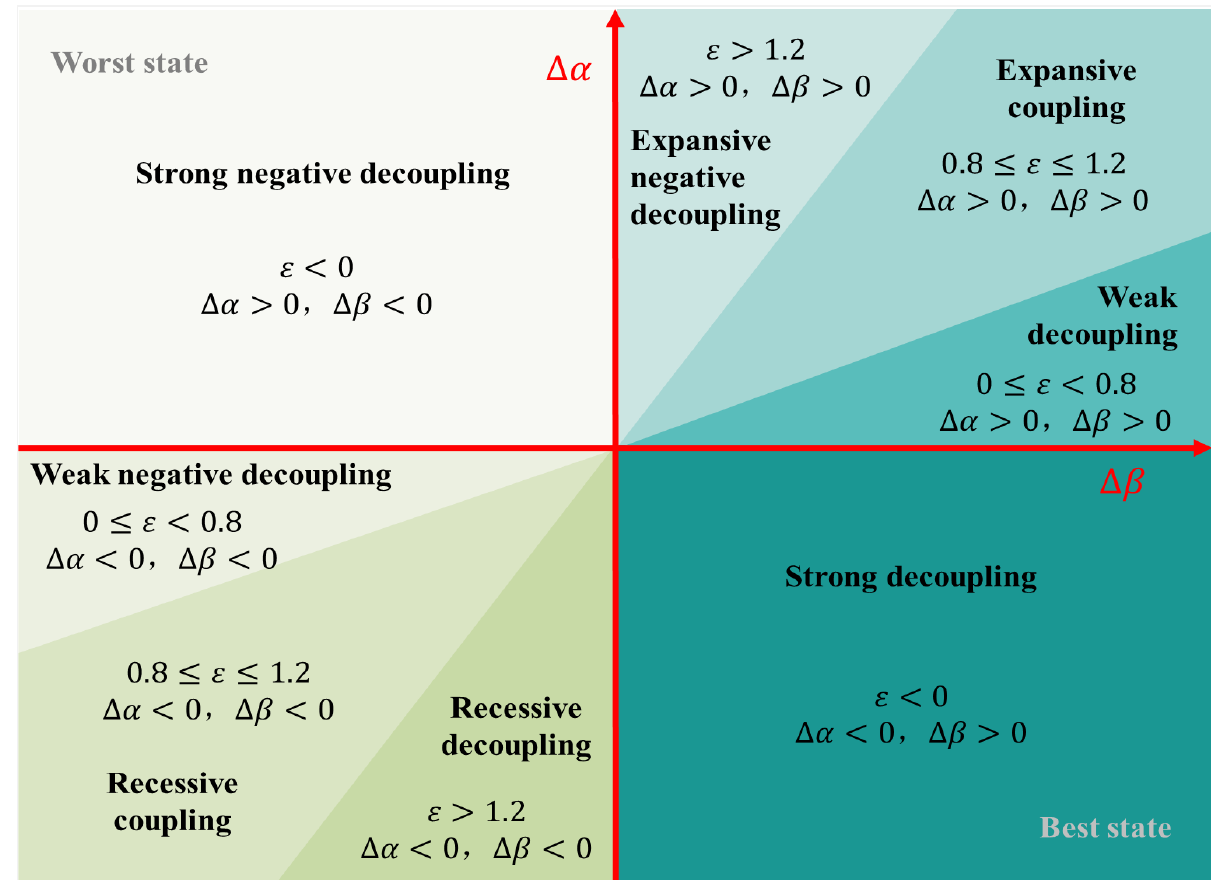
Figure 3. Decoupling type and Decoupling indicator range.